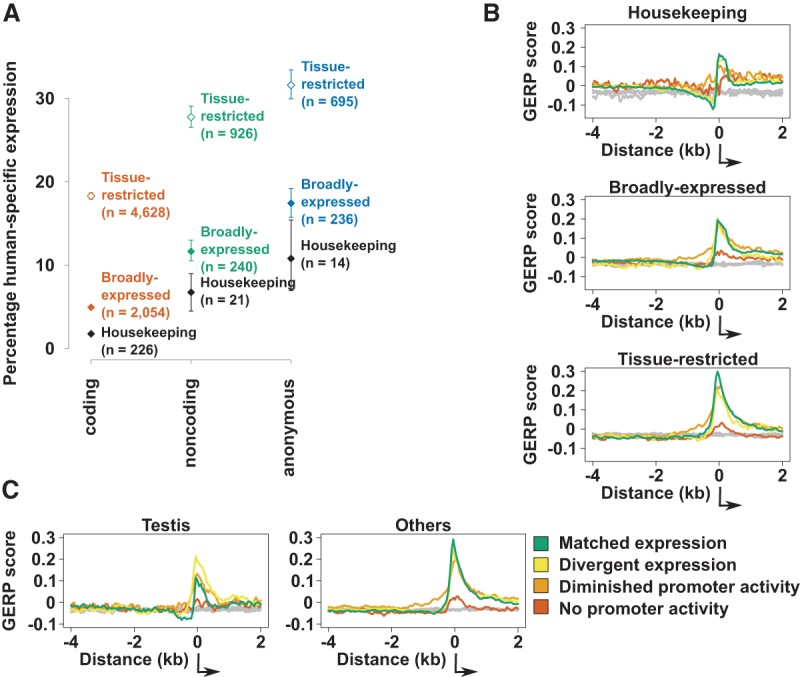
Expression turnover at aligned promoters. (A) The percentage of human promoters of a particular class and expression profile which can be aligned to mouse but show no transcriptional activity at the aligned position. The error bars represent the 95% confidence interval from 1000 samplings of the data with replacement. (B,C) Mean GERP conservation scores in 50-bp windows around human protein-coding promoters with different evolutionary outcomes. Gray lines indicate the GERP scores for genome permuted intervals. The standard error of these mean scores is negligible and not visible on this scale. The direction of transcription is shown by the black arrows. The sample sizes of promoters contributing to each line are detailed in Supplemental Table 3.